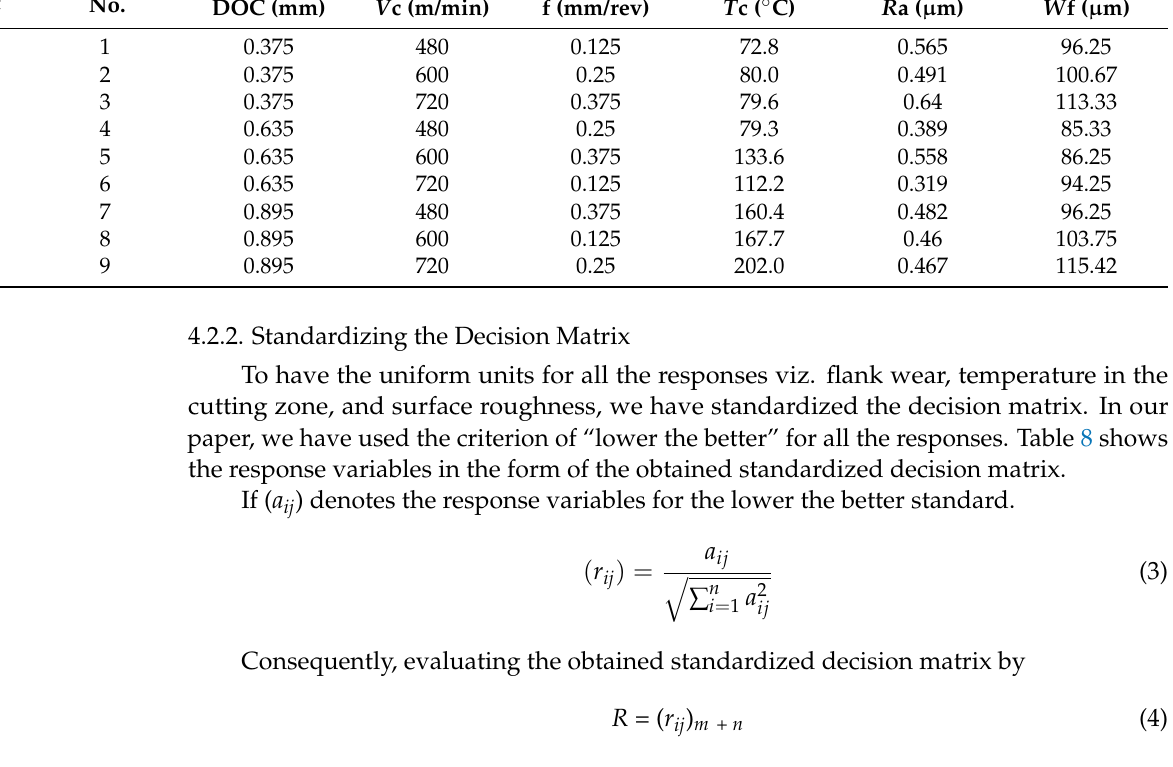
Table 7. L 9 orthogonal array along with the response variables in the form of initial decision matrices. Order of